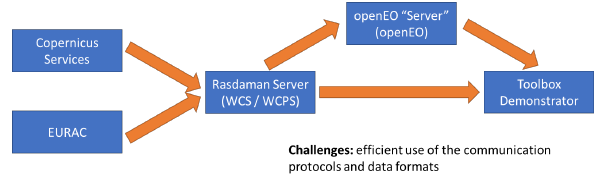
Figure 2. Relationship between data servers, Rasdaman server and our demonstrator toolbox providing the end user with data visualizations.